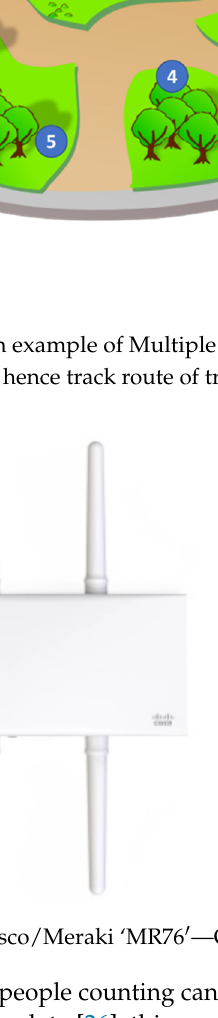
Figure 1. An example of Multiple WiFi Sensors (sensors 1-5) installed across a Forest Trail to track devices and hence track route of travel